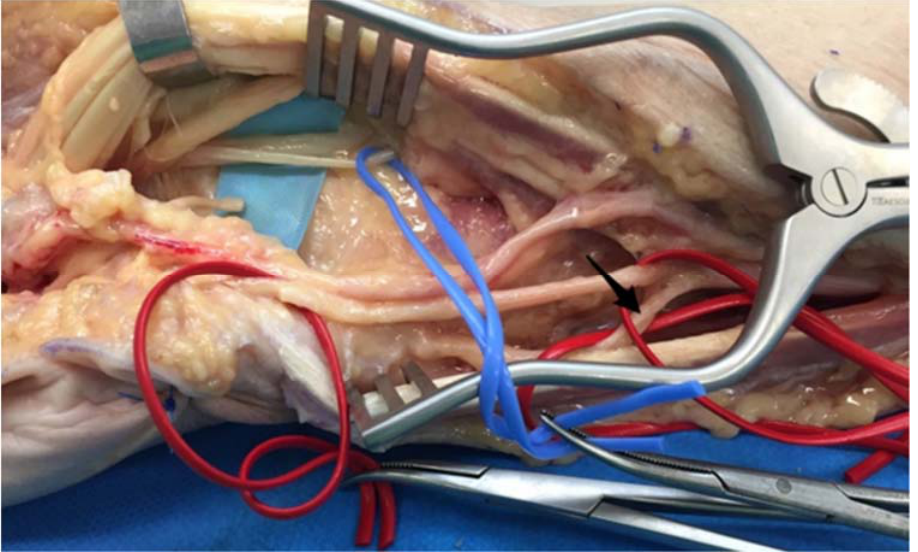
Figure 4. Isolation of the fascicle for the 3 web space and the DoBUN. The ulnar nerve was isolated in the red vessel loop. Between the flexor tendons, the median nerve was identified, and interfascicular dissection of the median nerve was carried out to isolate the fascicle for the third web space (blue loop).